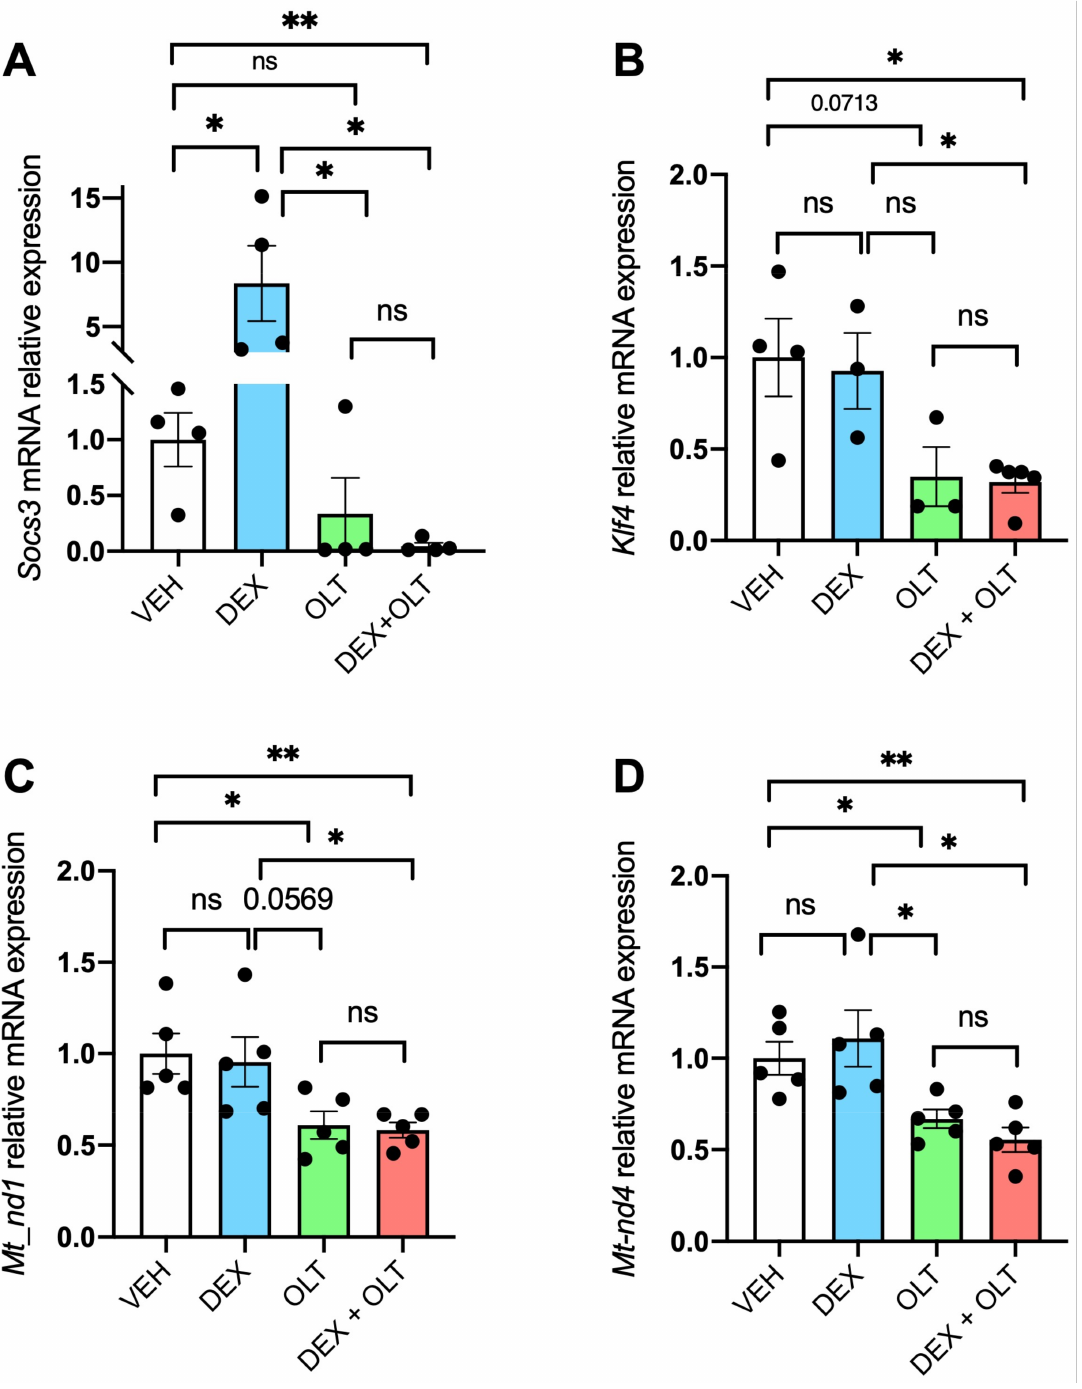
Figure 2. STAT3 transcriptional activity is inhibited by OLT1177 and dexamethasone. Total RNA was extracted from primary tumor samples and RT-qPCR was performed for ( A ) Socs3 , ( B ) Klf4 , ( C ) Mt-nd1 , ( D ) and Mt-nd4 . Data are presented as mean ± SEM. * p < 0.05; ** p < 0.01; ns = not